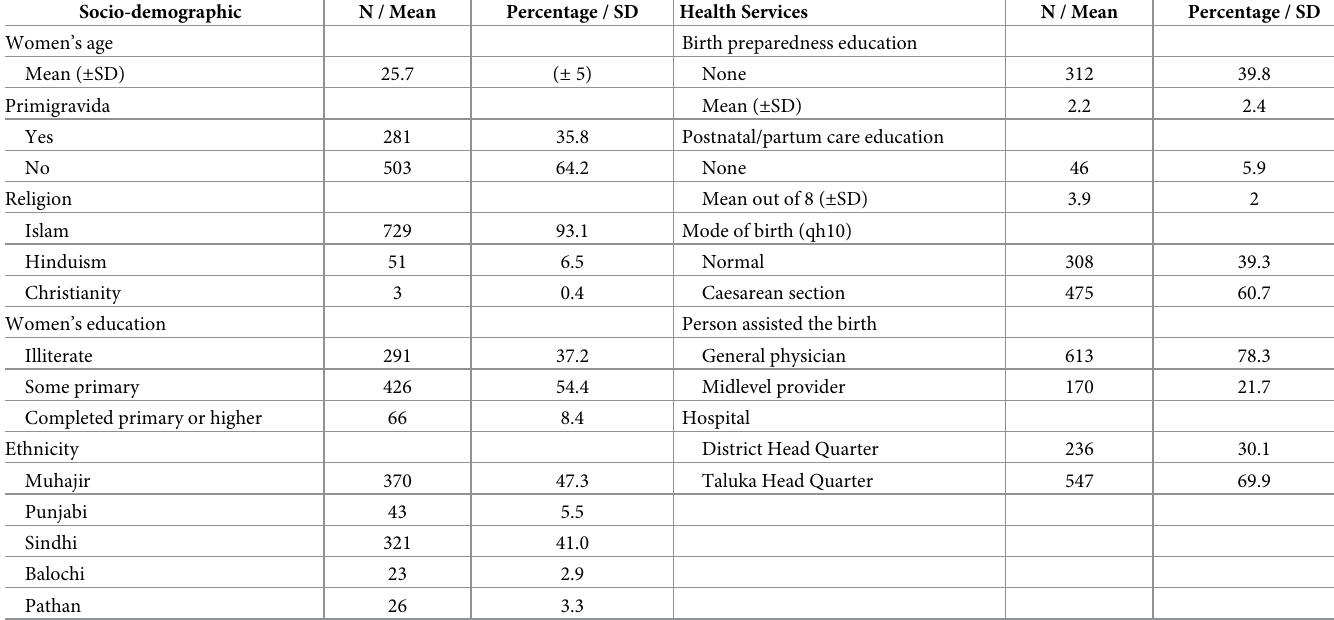
Table 1. Characteristics of the study